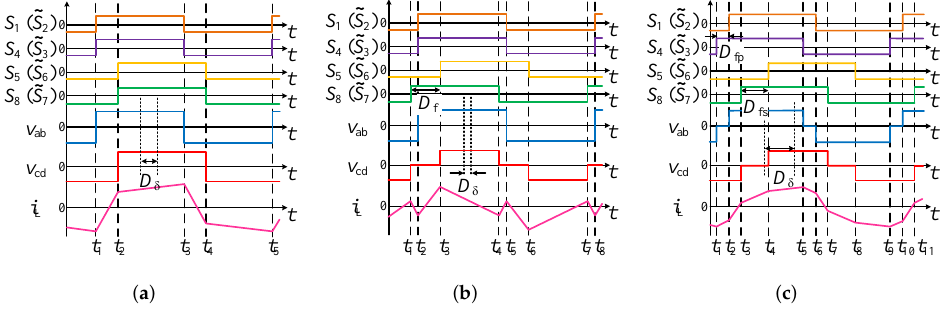
Figure 2. Schematic waveforms of the DAB converter with the ( a ) SPS modulation, ( b ) EPS modula- tion, and ( c ) TPS